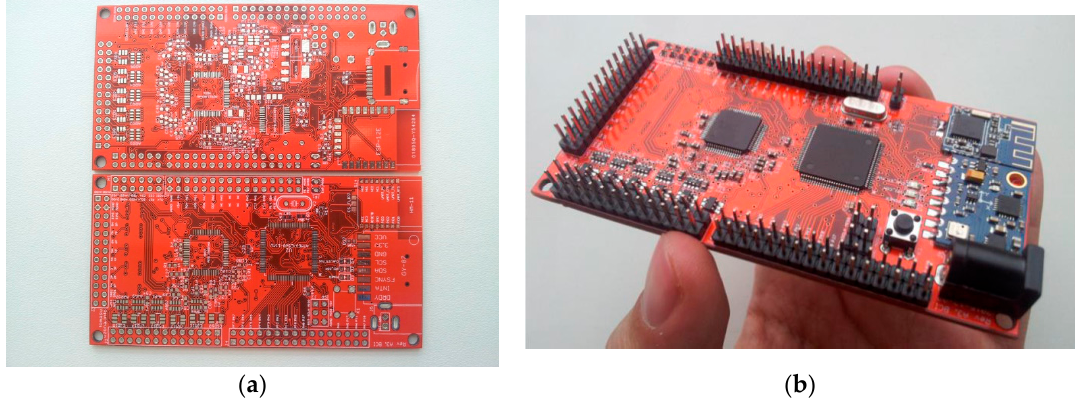
Figure 2. The designed PCB ( a ) Top and bottom of the board; ( b ) Initial version of finished system PCB (dimensions are 10 cm × 5 cm).